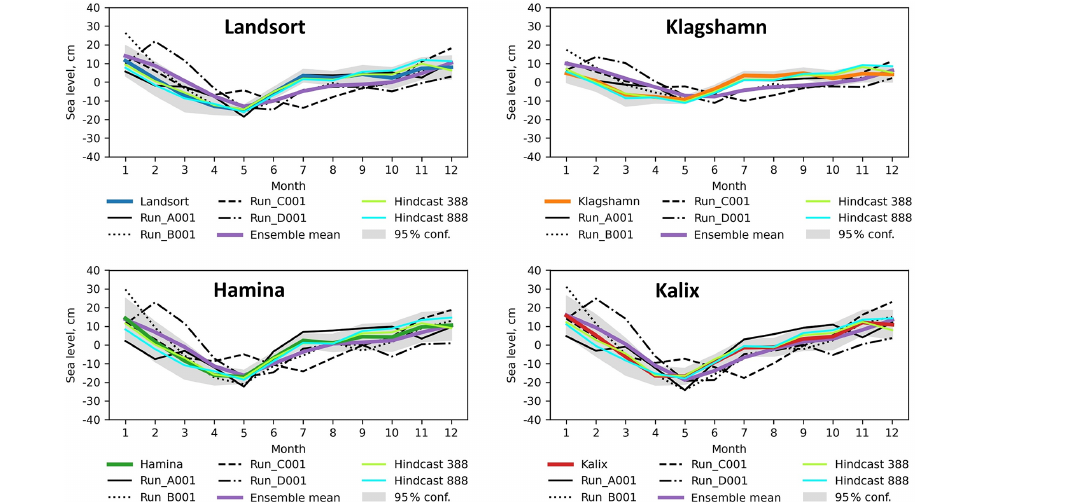
Figure 8. Monthly mean sea level according to a hindcast (driven by a regionalised reanalysis of atmospheric surface fields, i.e. RCA4 driven by ERA-40; hindcast 388), reanalysis with the data assimilation of Liu et al. (2017) (hindcast 888) and four climate simulations following Saraiva et al. (2019a) (Run_A001,...,Run_D001), the ensemble mean and observations for the historical period 1976–2005 at the sea level stations Klagshamn, Landsort, Hamina and Kalix (for the locations, see Fig. 1). The 95% confidence interval of the observations is shown as a grey-shaded